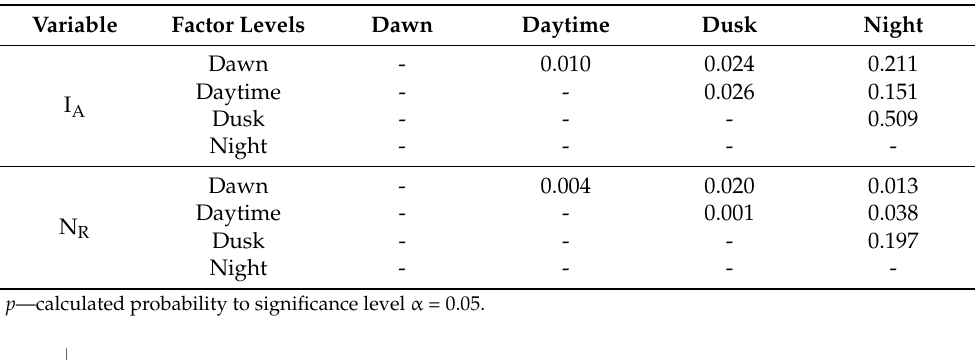
Table 4. Results of univariate PERMANOVAs pairwise tests ( p 1 ) regarding the daily variation of the dusky groupers activity index (I A ) and the number of receivers with detections per hour (N R ) in the Pessegueiro island and Martinhal Islets study areas.